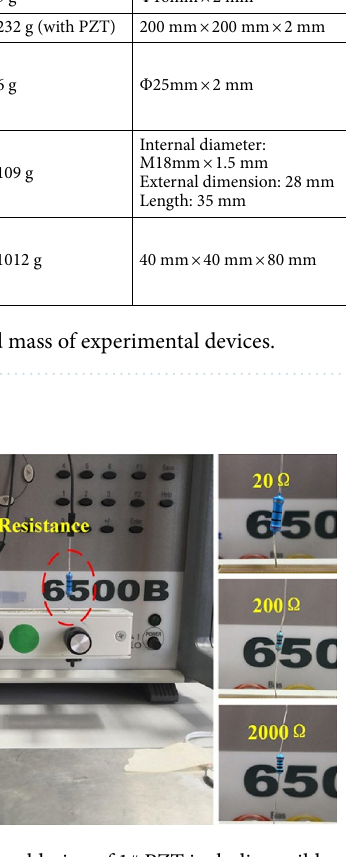
Figure 4. Pseudo soldering of 1# PZT including mild pseudo soldering (20Ω), moderate pseudo soldering (200Ω), and severe pseudo soldering